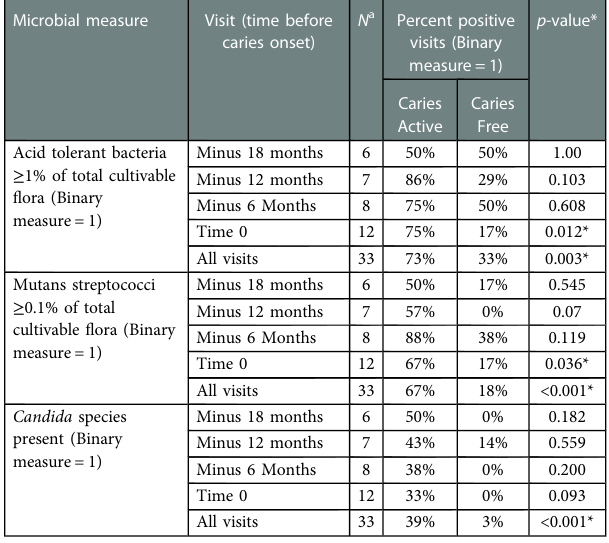
TABLE 3 Mean plaque microbial index (PMI) per visit at each designated time point ahead of caries diagnosis. Visit (time before caries onset)